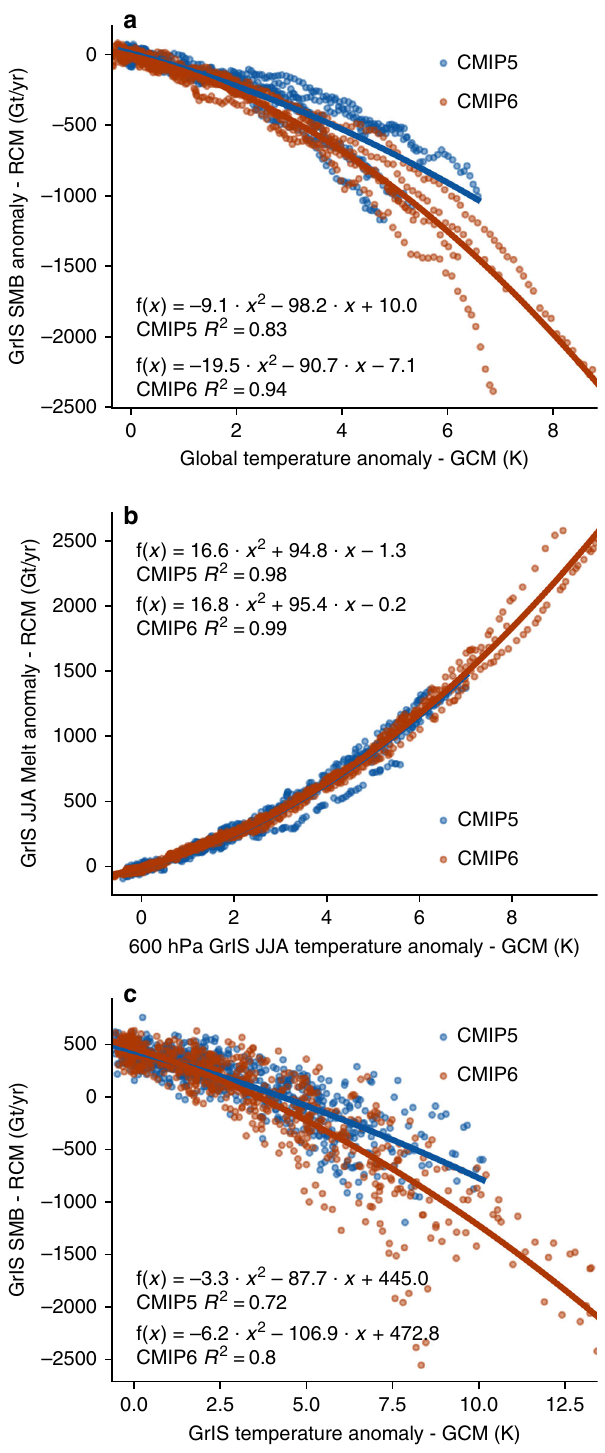
Fig. 4 Statistical comparison between GCM temperature anomalies and GrIS melt and SMB anomalies from regional climate simulations. a Scatterplot of 10-year running means of the annual global temperature anomalies from the six CMIP5 (RCP8.5) and fi ve CMIP6 (SSP585) GCM models ( x -axis) and the dynamically downscaled MAR GrIS SMB anomalies ( y -axis) in gigatonnes (Gt). The orange and blue lines are second-order polynomials fi tted to the data ( “ least squares ” ), where the function is given in the fi gures alongside the R 2 correlation scores. The anomalies are computed for the 1961 – 1990 mean state. b Same as a but for the comparison between 600 hPa JJA temperature anomaly over the Greenland domain (60°N – 85°N, 20°W – 70°W) vs. the GrIS melt anomaly during summer (JJA) in gigatonnes (Gt). c Same as b but for the comparison between the Greenland (60°N – 85°N, 20°W – 70°N) 2 m annual temperature anomaly (GCMs) and the annual GrIS surface mass balance